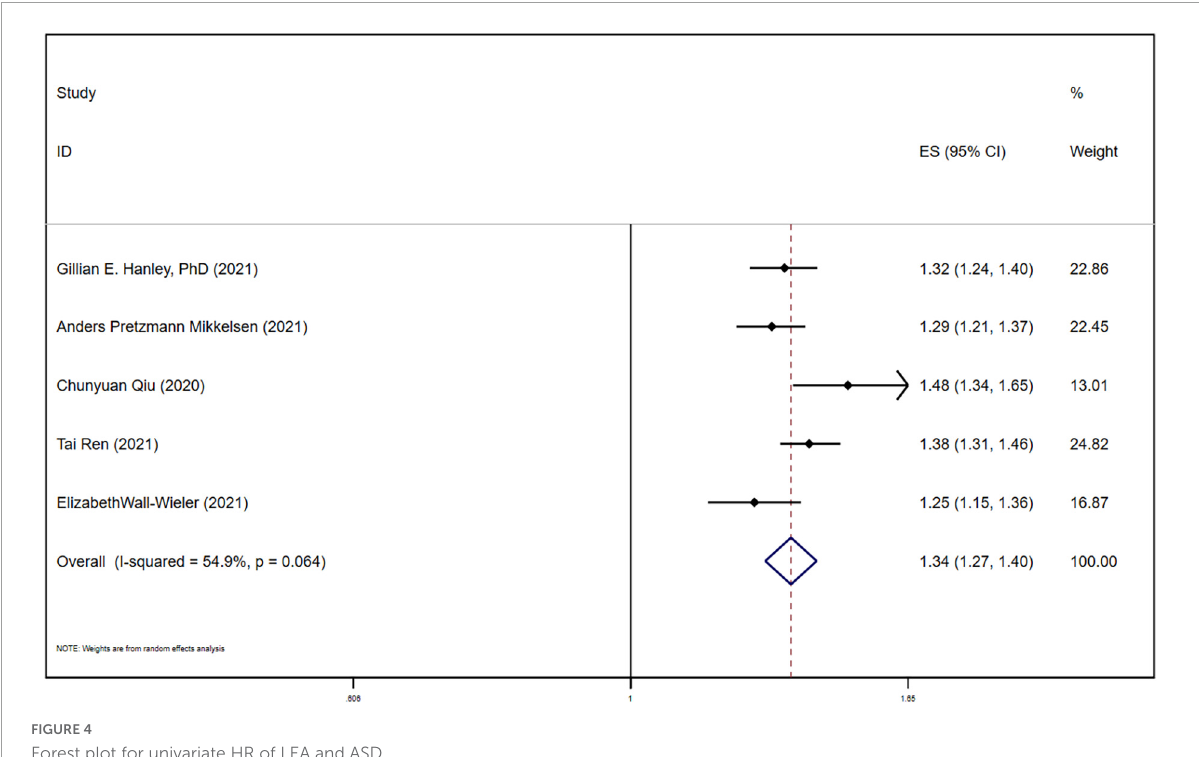
FIGURE4 Forest plot for univariate HR of LEA and ASD.